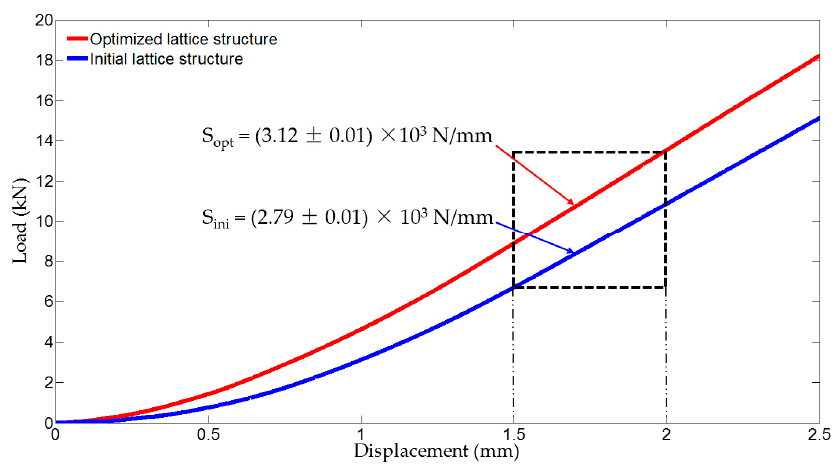
Figure 25. Load–displacement curves for experimental verifications.